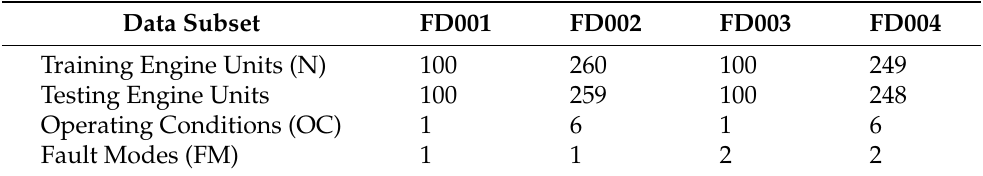
Table 1. The C-MAPSS